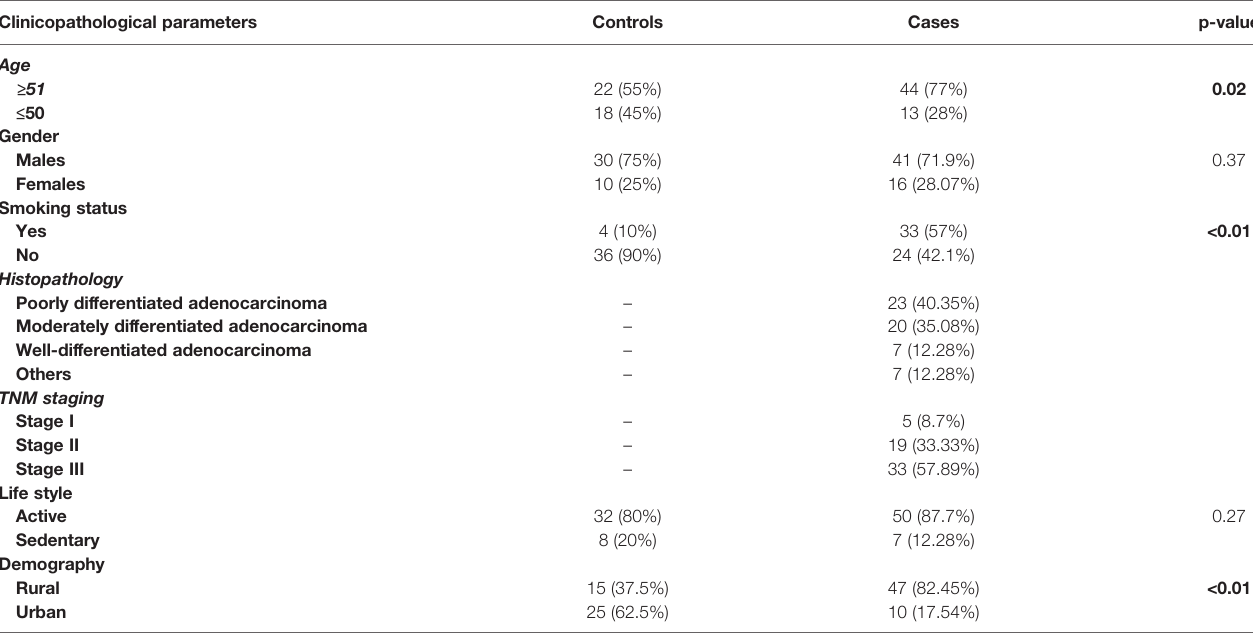
TABLE 1 | The various characteristic features of gastric cancer patients. Clinicopathological